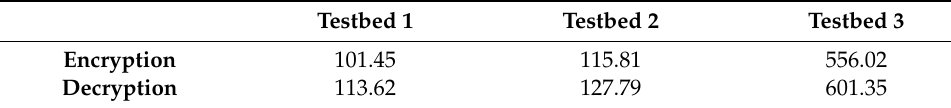
Table 1. Results Table 1. Results (milliseconds)